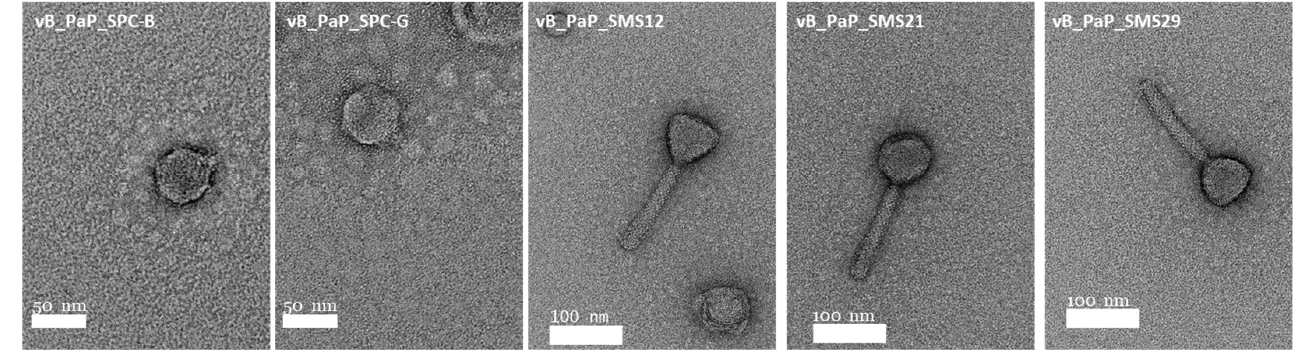
Figure 1. Virion particle morphology of P. aeruginosa PAO1 phages observed by TEM. Plaque morphologies varied from tiny (1 mm) to big (5 mm), and the plaque + halo (p + h) diameters ranged between 3 and 35 mm (Figure 2). SPCB and SPCG had considerably larger plaques (p) which did not alter with time, and haloes that increased, since the start (Figure 2A), at average speeds of 0.41 ± 0.24 and 0.43 ± 0.18 cm/day until 168 h, respectively (Figure 2C). In addition, the lysis zones of SPCB and SPCG had significant numbers of colonies already after 24 h. The haloes of SMS12, SMS21, and SMS29 were smaller (p + h, Figure 2B) and started to increase after 96 h at average speeds of 0.51 ± 0.33, 0.48, and 0.69 ± 0.35 cm/day (Figure 2D), respectively.